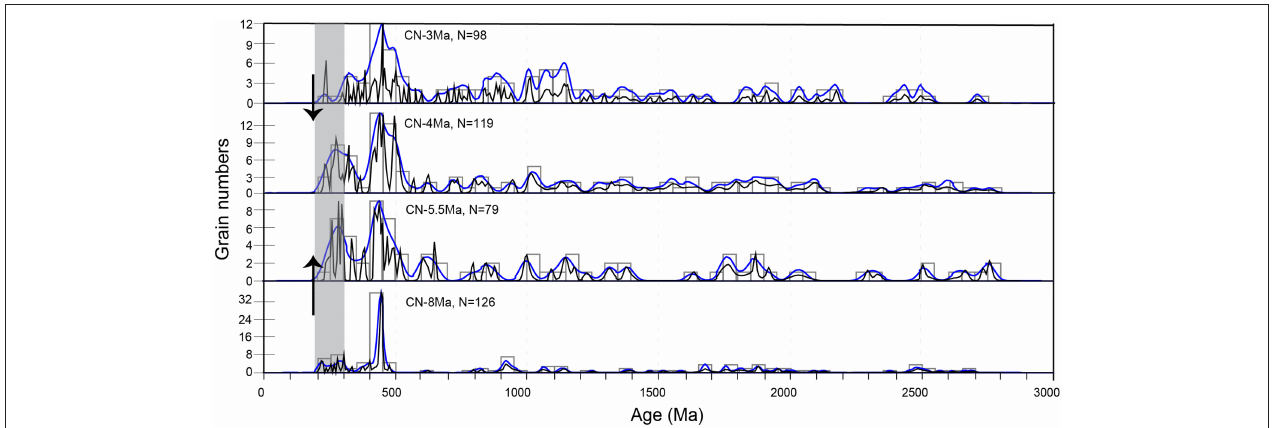
FIGURE 2 | A comparison of detrital zircon U–Pb ages between ∼ 3 Ma, ∼ 4 Ma, ∼ 5 Ma, and ∼ 8 Ma red-clay from Chaona (CN) (Nie et al., 2014a). Black and blue lines are normalized probability density plots and Kernel Density Estimation plots, respectively, and the open rectangles are age histograms. The shaded bar marks the age range 300–200 Ma and the upward and downward arrows indicate the upsection increase and decrease of the 300–200 Ma age population, respectively.